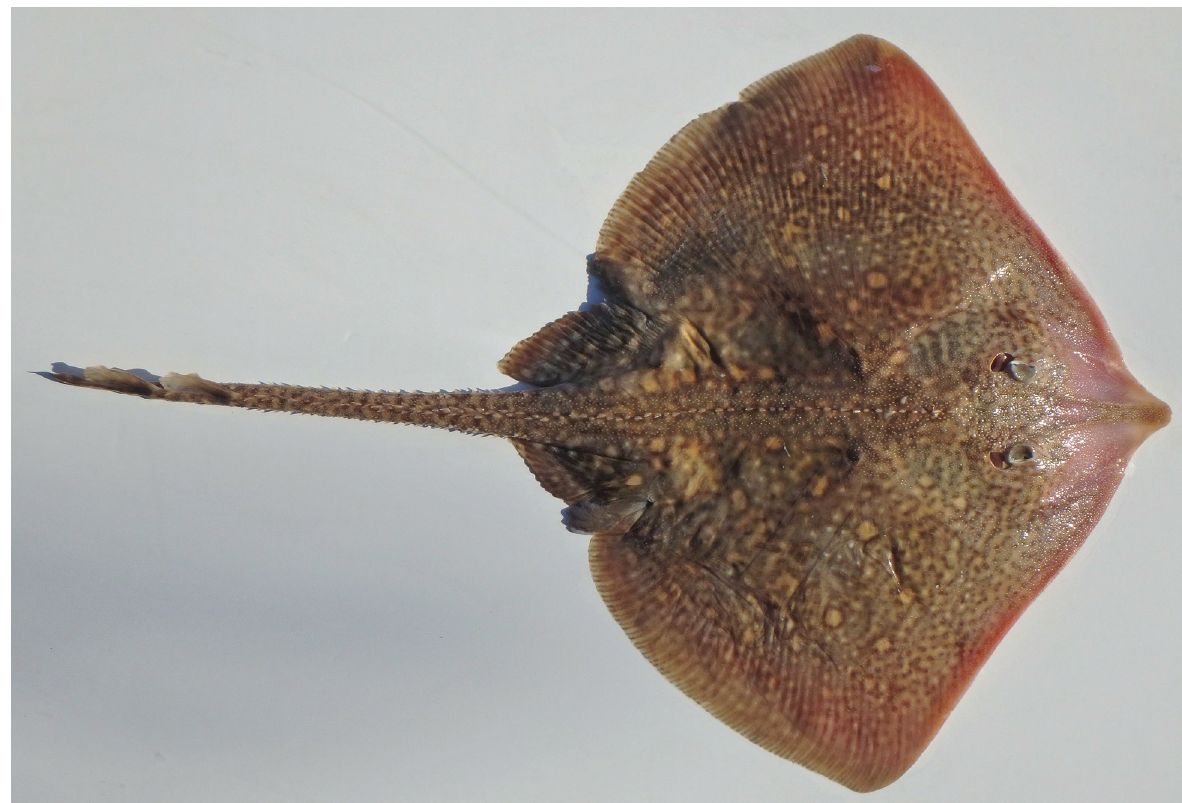
Fig. 2. Dorsal view of Raja asterias (CFM-IEOMA6087) collected from the Gulf of Cádiz